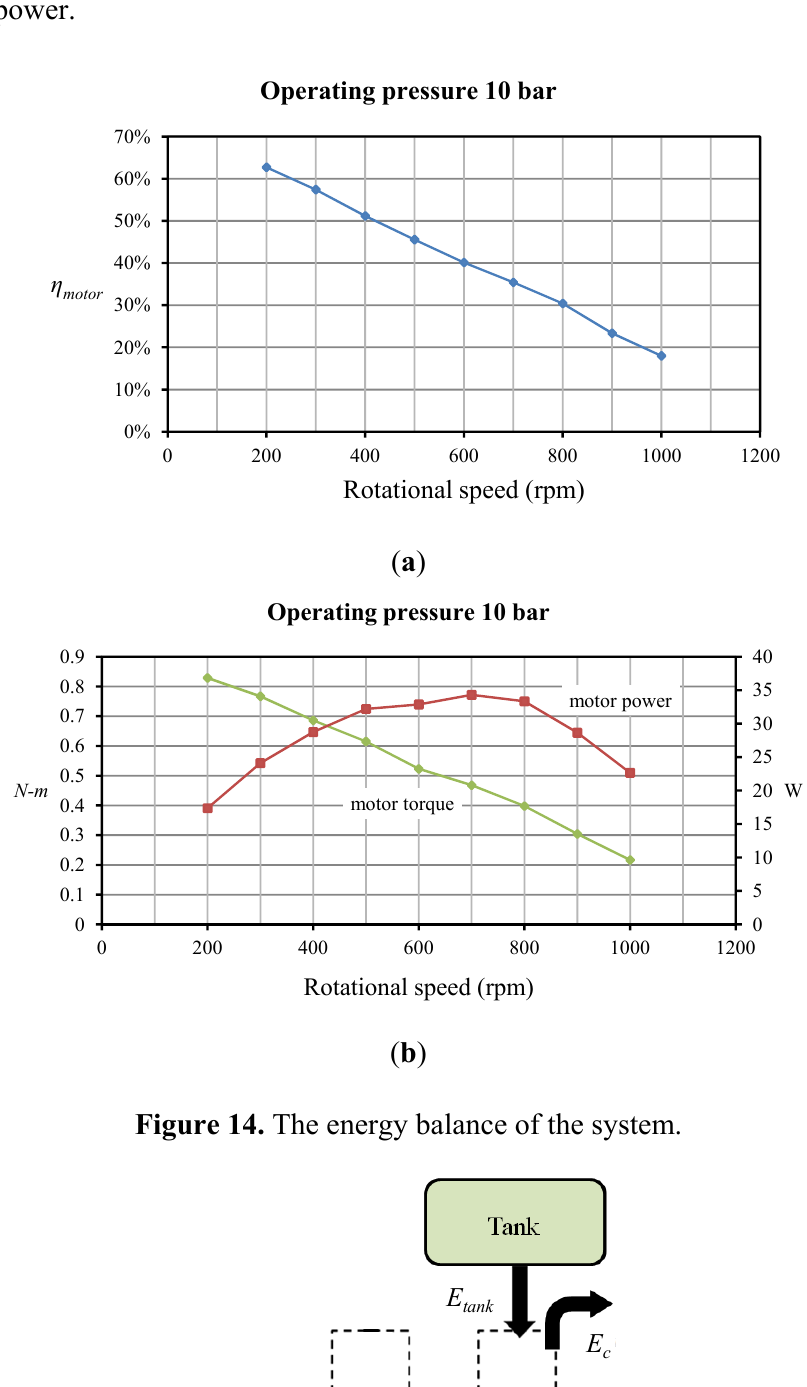
Figure 13. ( a ) The hydraulic motor efficiency and ( b ) the hydraulic motor output torque and output power.